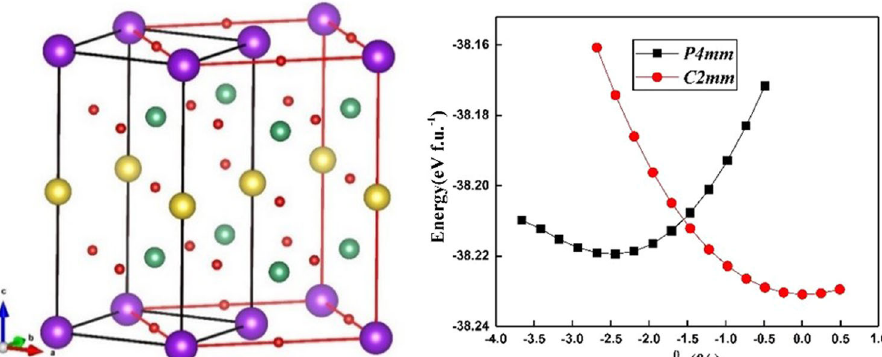
Fig. 2 Relevant results of DFT theoretical calculation. a Schematic diagram of ideal paraelectric KNN structure. The K/Na atom in the structure are ordered along [001] direction. The atoms in yellow, purple, green, and red are K, Na, Nb, and O, respectively. The unit cell in black frame and the supercell in red frame contains 10 and 20 atoms, respectively, and will be used in our calculation for different KNN phases, i.e., P4mm (10 atoms) and C2mm (20 atoms). b Free energies of the P4mm and C2mm phases as functions of the mis fi t